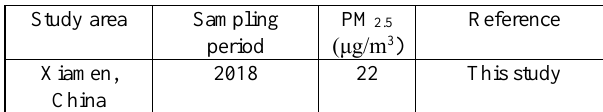
(Veneto) and Greece